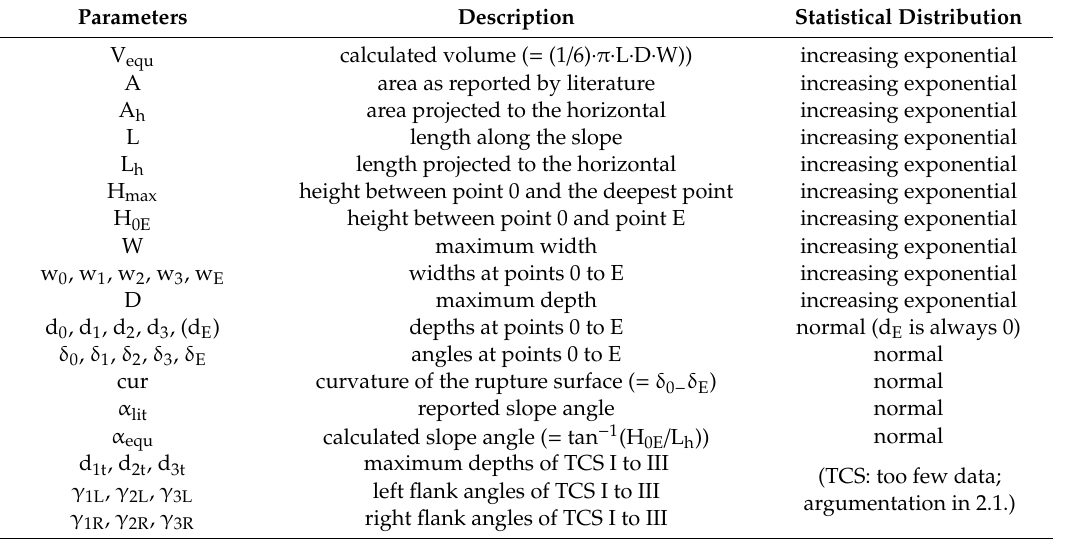
Table 1. Description of parameters defining a landslide rupture zone (adapted and further developed from the IAEG Commission on Landslides [33]). The last column indicates the type of statistical distribution of values per individual parameter throughout the